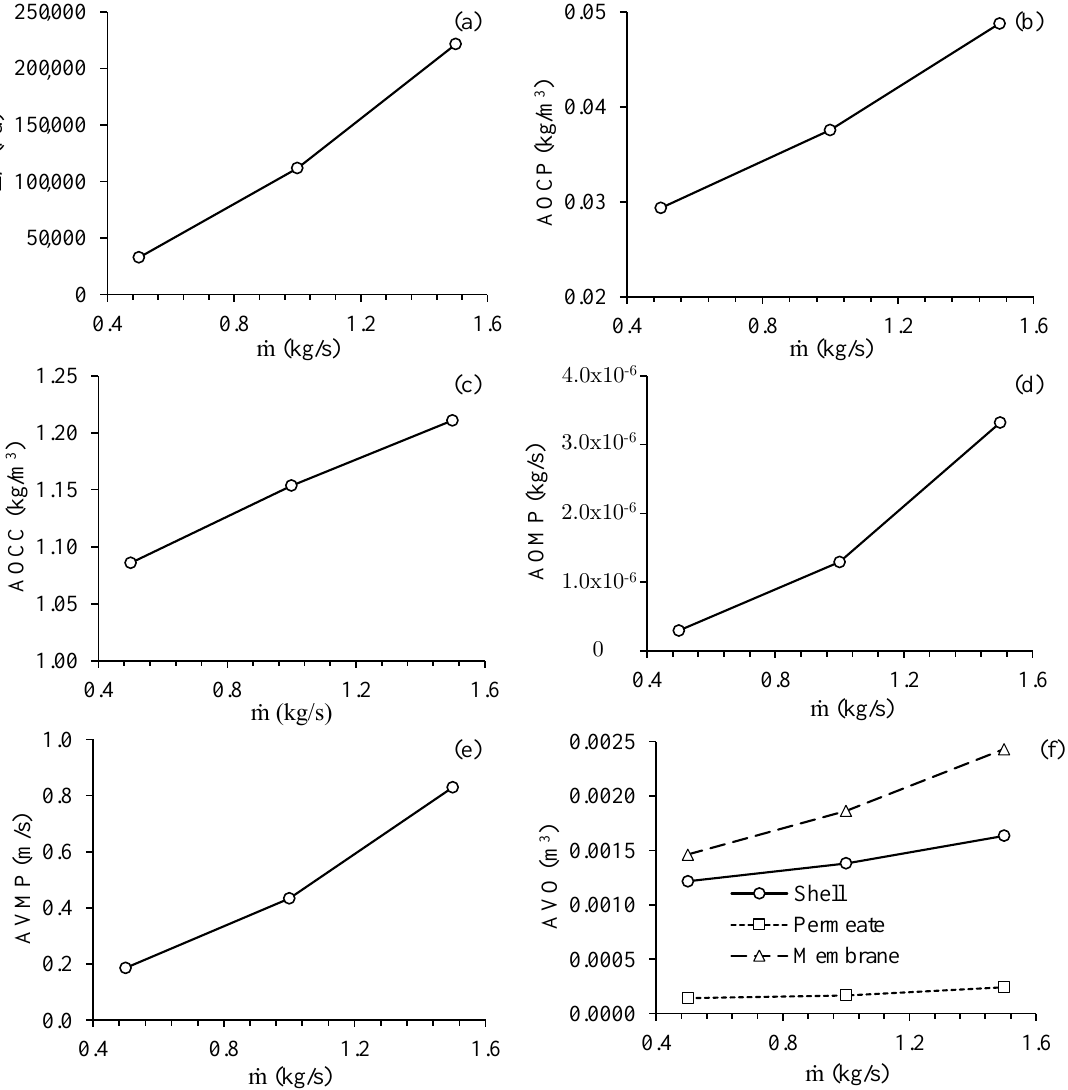
Figure 10. Process parameters in the filtration module as a function of the mass flow rate of fluid in the feed. ( a ) Transmembrane pressure, ( b ) average oil volumetric concentration at the permeate outlets, ( c ) average oil volumetric concentration at the concentrate outlet, ( d ) average oil flow rate at the permeate outlets, ( e ) average fluid velocity in the permeate outlets and ( f ) average volume of oil present in the hull, membranes and permeate (Cases 2, 4 and 5).